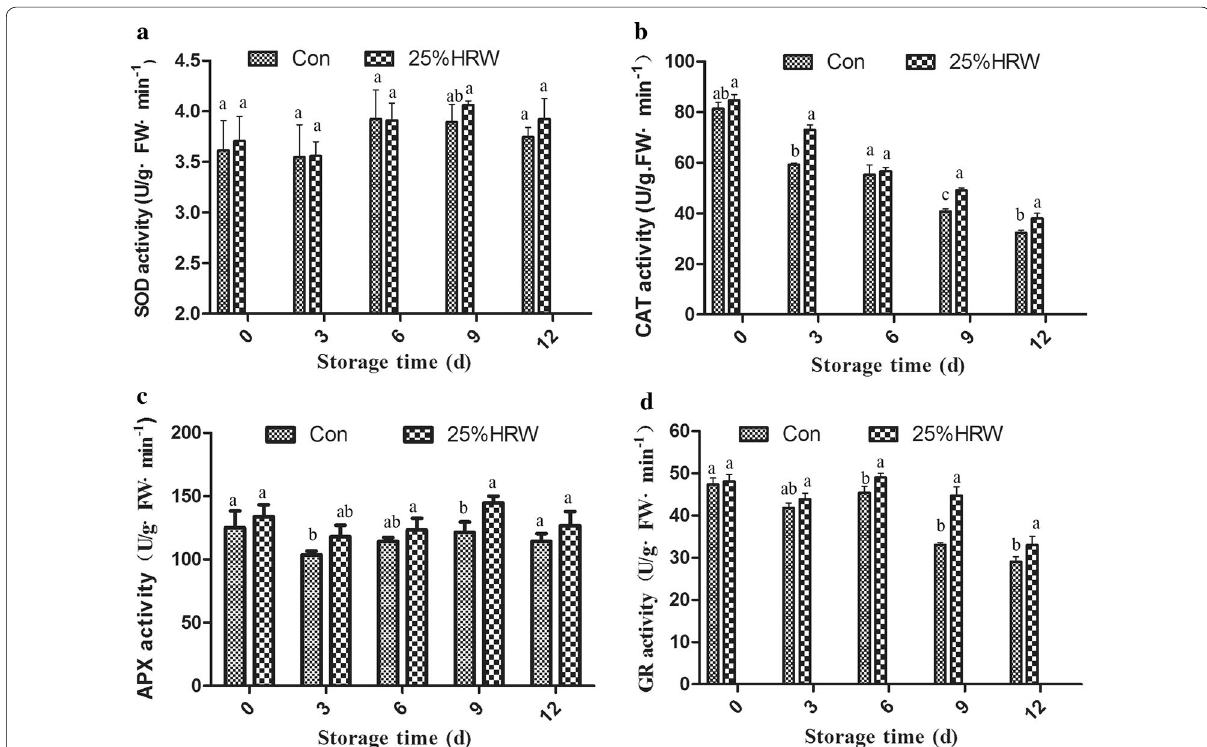
Fig. 5 Effects of HRW on the antioxidant enzyme activities of SOD ( a ), CAT ( b ), APX ( c ) and GR ( d ) in fruit bodies of Hypsizygus marmoreus during storage at 4 °C. SOD superoxide dismutase, CAT catalase, APX ascorbate peroxidase, GR glutathione reductase, Con control group. The data are pre- sented as the mean SD of three independent experiments. Bars with different letters denote a statistically significant difference compared with ± the control according to multiple comparisons (P <